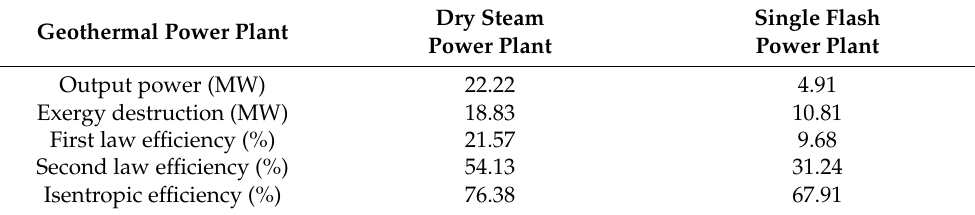
Table 4. Thermodynamic result of dry steam and single flash